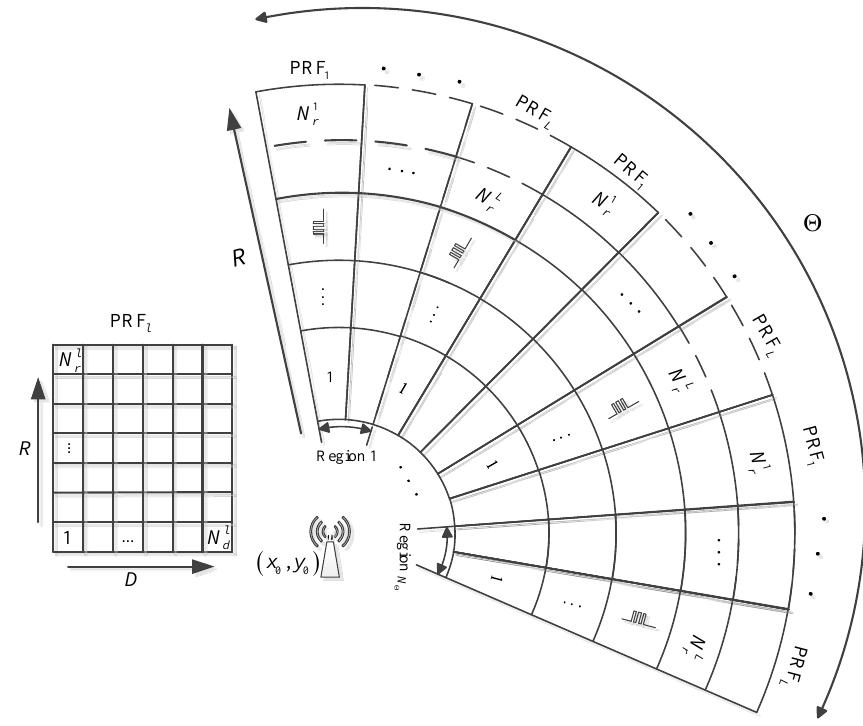
Figure 1. The radar surveillance region in the radial range, angle, and Doppler dimensions.